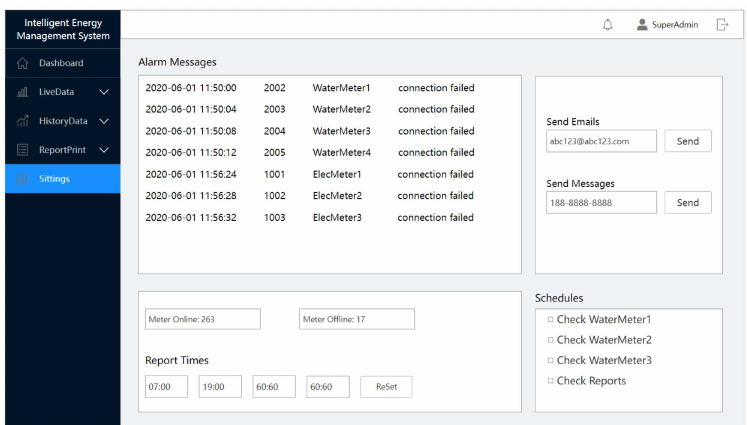
Figure 10. Settings